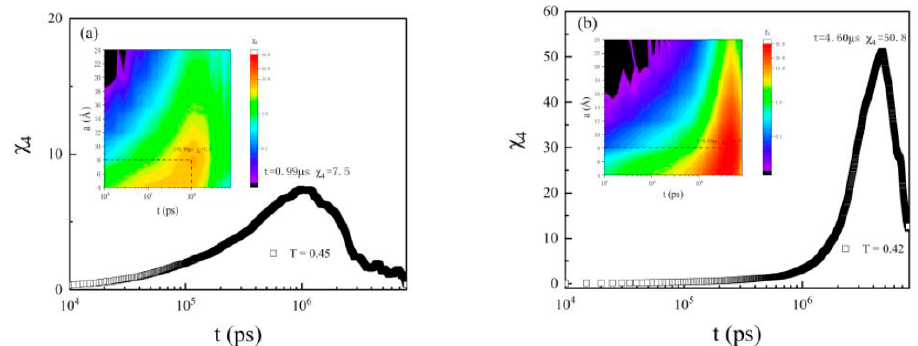
Figure 6. Dynamical susceptibility, χ 4 for PS monomers at different probe length scales and time scales, at ( a ) T = 0.45 and ( b ) T = 0.42. The maximum dynamic susceptibility was 7.5 at t = 0.99 μ s at T = 0.45, and 50.8 at t = 4.6 μ s at T = 0.42, respectively. The insets show the trends of χ 4 with different a and t. The dash lines in the insets were used to indicate the maximum of χ 4 .